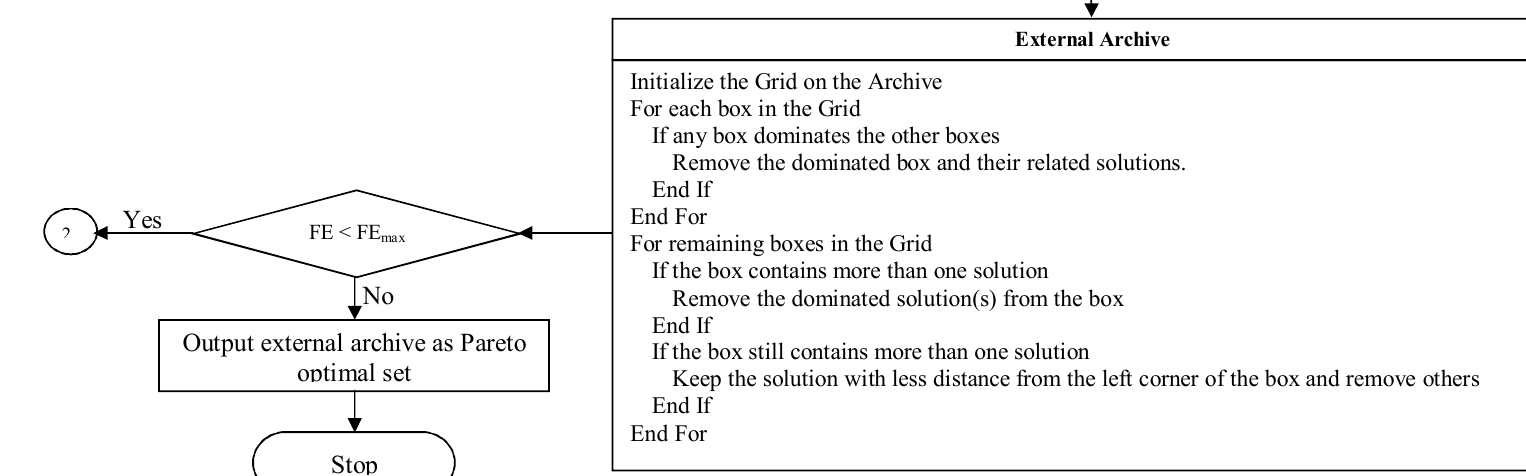
Fig. 2. Schematic diagram of the MO-ITLBO